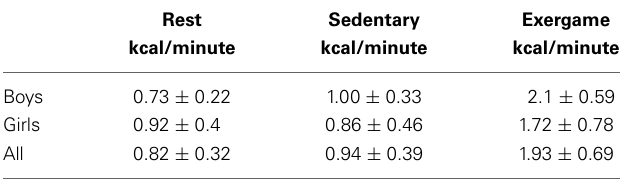
Table 3 | Kilocalories (kcal) per minute. Rest